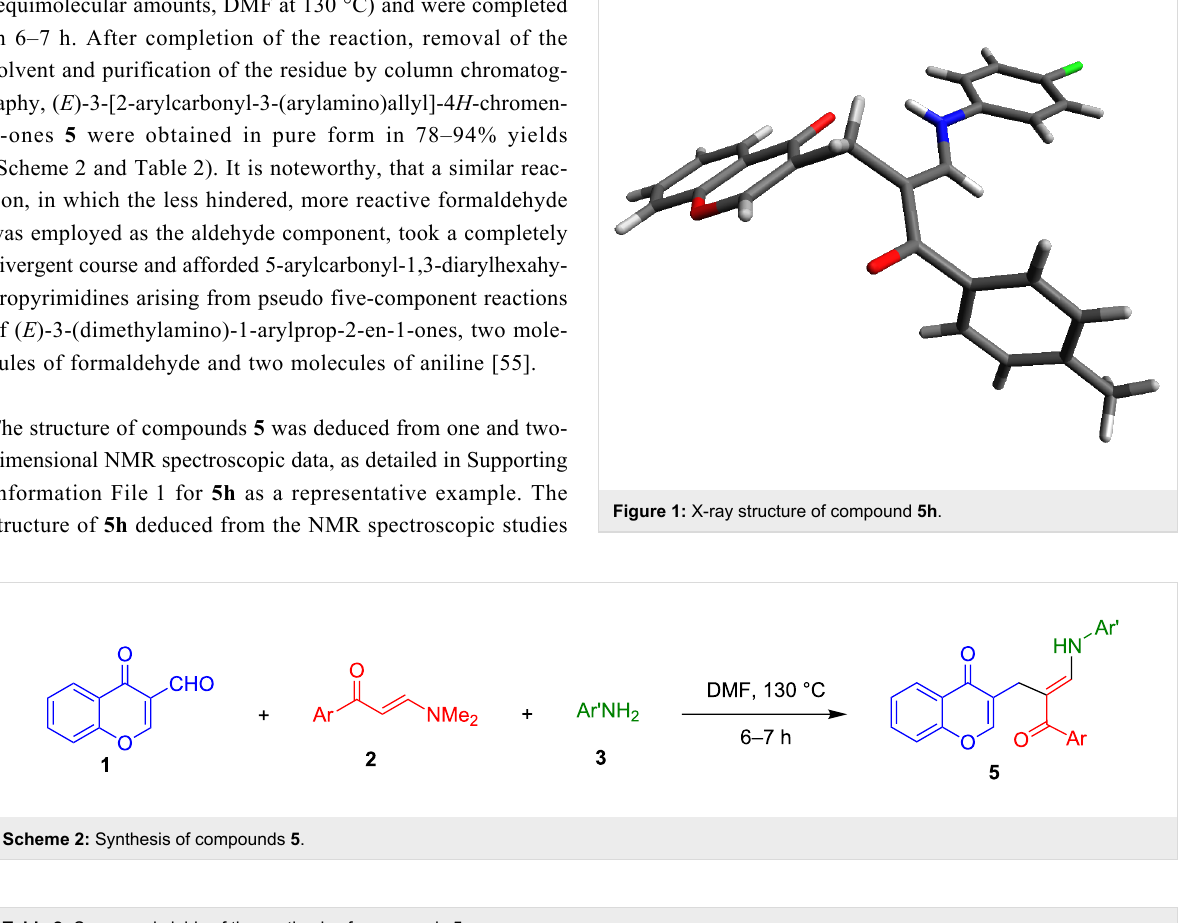
Table 2: Scope and yields of the synthesis of compounds 5 .